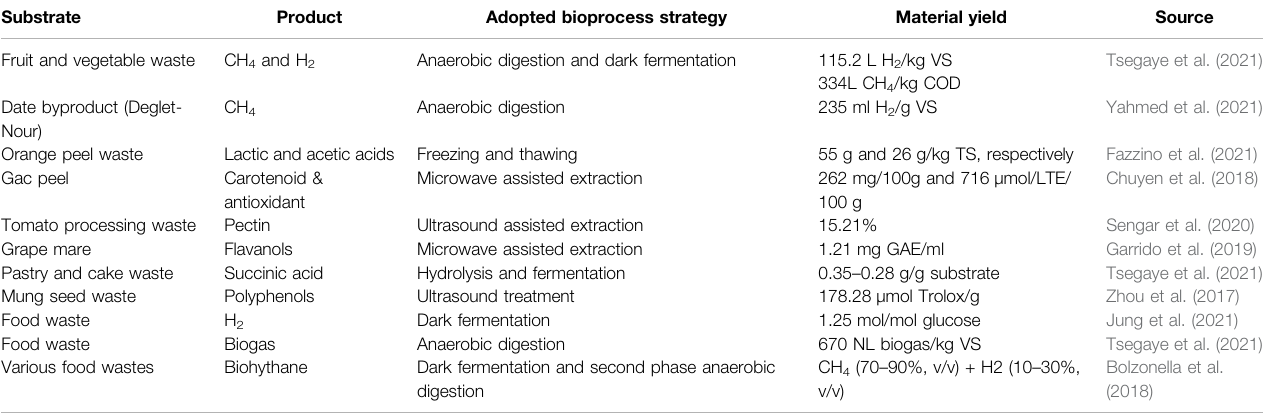
TABLE 2 | Various products produced through the food waste biore fi